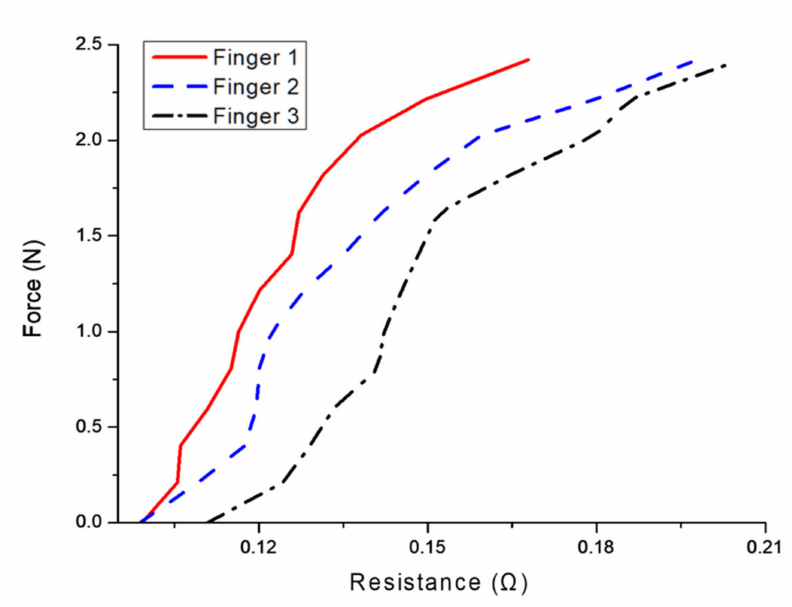
Figure 25. Graph of force on each finger of the gripper according to the resistance of the correspond- ing